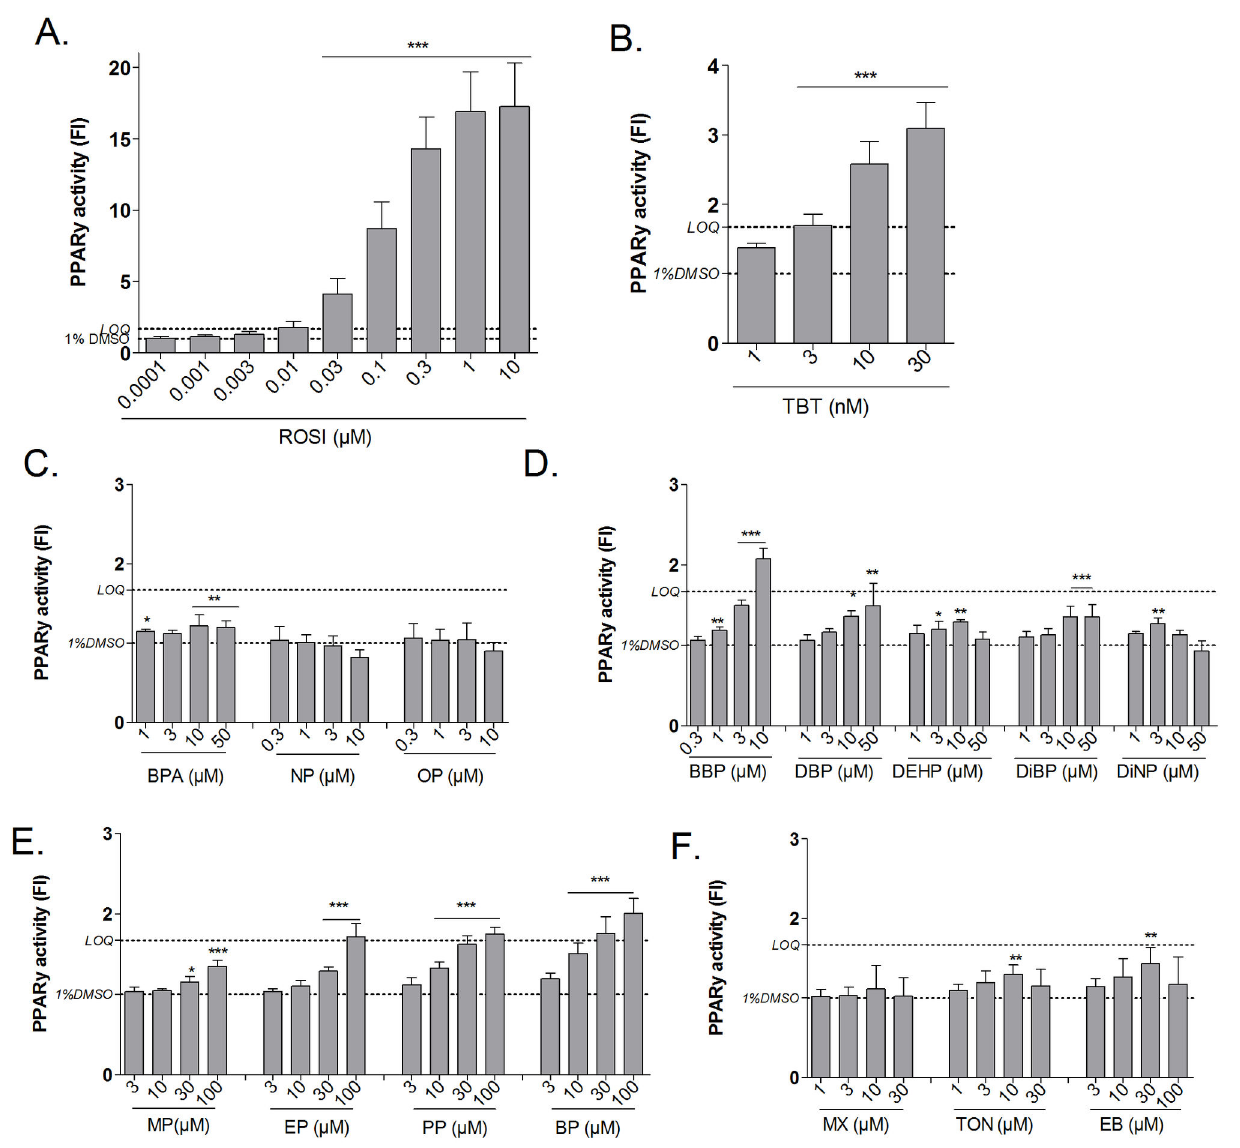
Figure 9. Effect of reference and test compounds on PPARγ activation in the PPARγ CALUX cell line. After 24h of exposure luciferase activity was measured with a luminometer. PPARγ activation of reference compounds ROSI (A.) and TBT (B.) and screened EDCs: Alkylphenol (C.), Phthalate (D.) Paraben (E.) and Musk (F) compounds are represented as mean (±SD) of the fold induction of at least three independent experiments performed in triplicate. Significant differences with solvent control (1% DMSO) are indicated with asterisks (One Way ANOVA Dunnet’s post hoc test; *p≤0.05; **p≤0.01; ***p≤0.001). LOQ limit of quantification . doi: